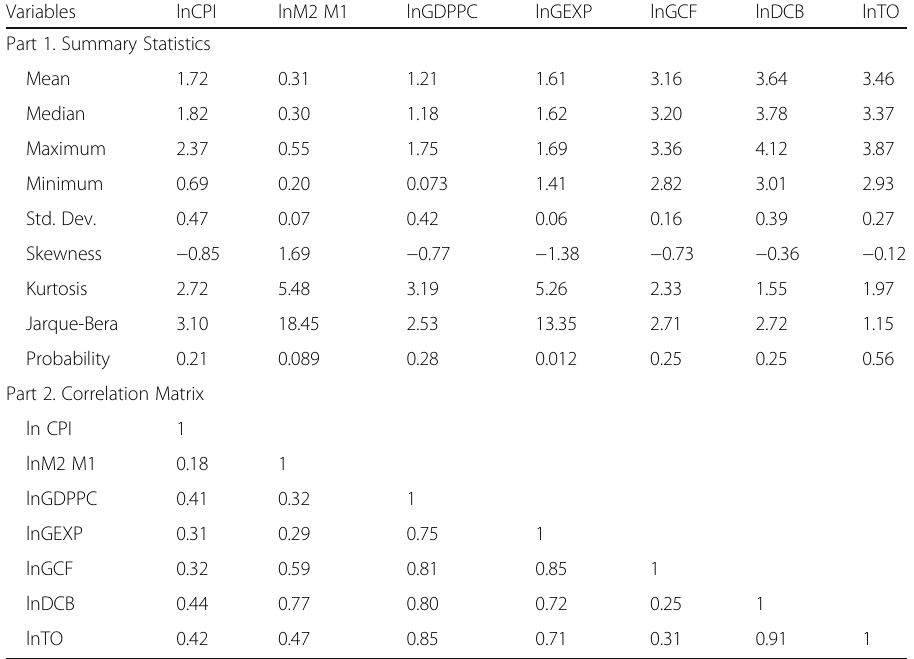
Table 2 Descriptive Statistics for the variables